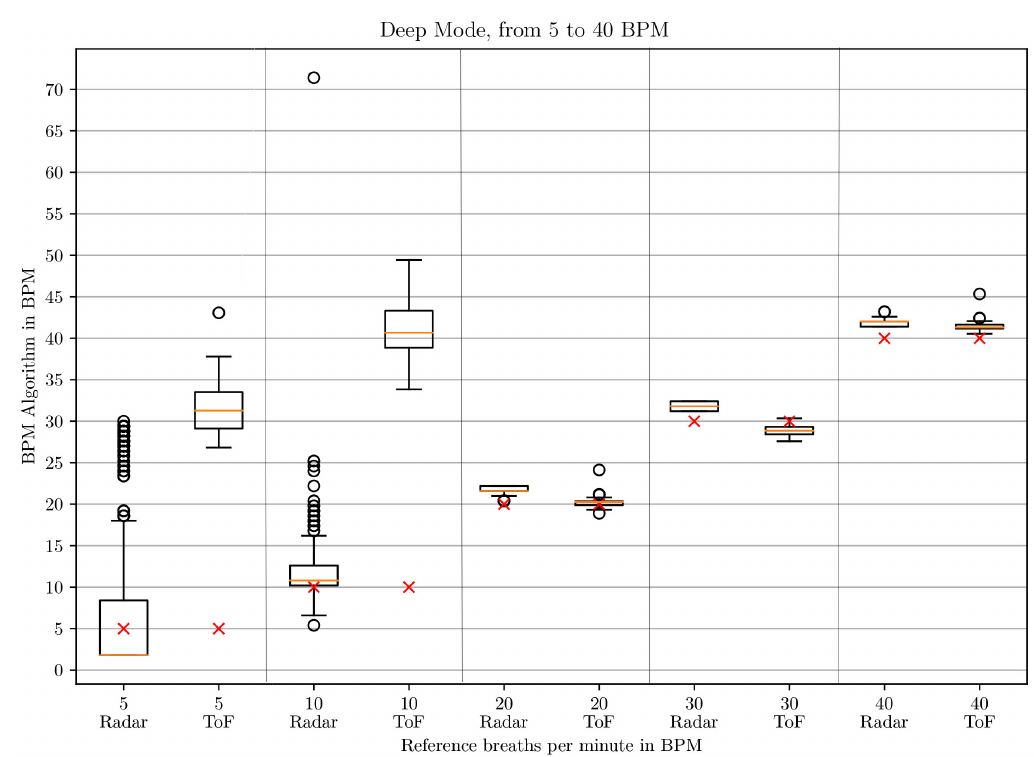
Figure 10. Box plot comparing the BPM values of the ToF and the radar algorithm for respiratory rates between 5 and 40BPM in deep mode.